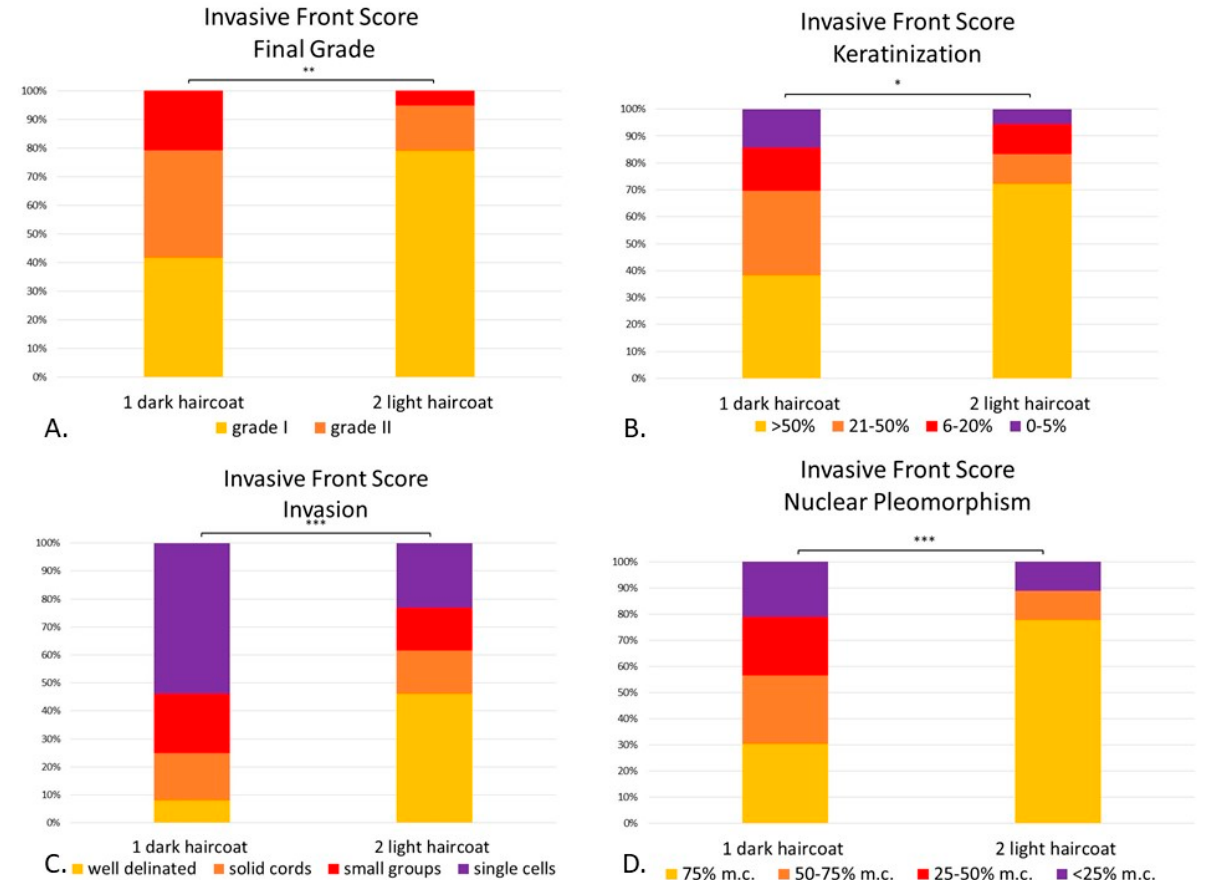
Figure 7. ( A – D ). Canine digital squamous cell carcinoma. Statistical differences between phenotypically dark-haired (Group 1) and light-haired (Group 2) dogs according to the invasive front system. There were statistical differences between Group 1 and 2 in final invasive front grading ( p < 0.01) ( A ), amount of keratinization within the invasive front ( p < 0.05) ( B ), pattern of invasion ( p < 0.001) ( C ) and degree of nuclear pleomorphism ( p < 0.001) ( D ). Mitoses and inflammation were not included given that they were not statistically significant between groups. * p < 0.05; ** p < 0.01, *** p < 0.001. Abbreviations: m.c.: mature cells.